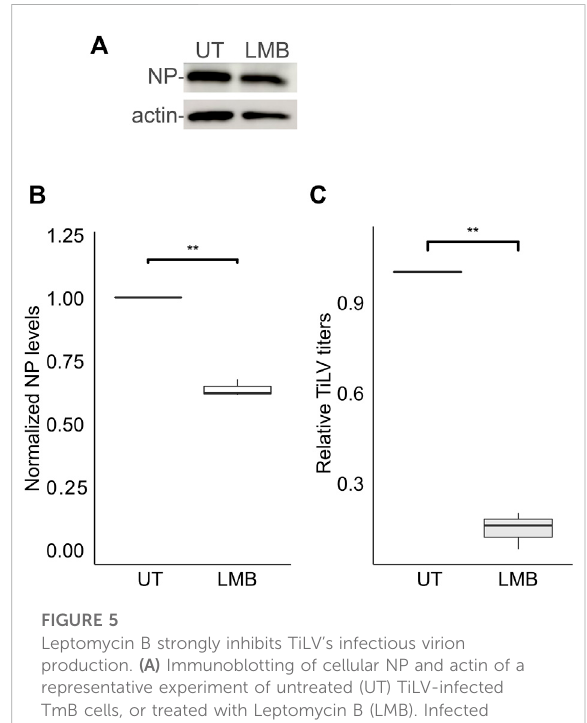
FIGURE 4 Ef fi cient TiLV entry requires the polymerization of actin and microtubules. (A) Immunoblotting of cellular NP and actin of a representative experiment of untreated (UT) TiLV-infected TmB cells, or treated with latrunculin A (Lat) or nocodazole (Noc), as in Figure 2A. (B,C) Boxplots showing measurements of three independent experiments for each indicated drug. (B) Normalized NP levels (calculated as in Figure 2C). (C) Relative TiLV titers (calculated as in Figure 2D). *, p ≤ 0.05; **, p ≤ 0.01.